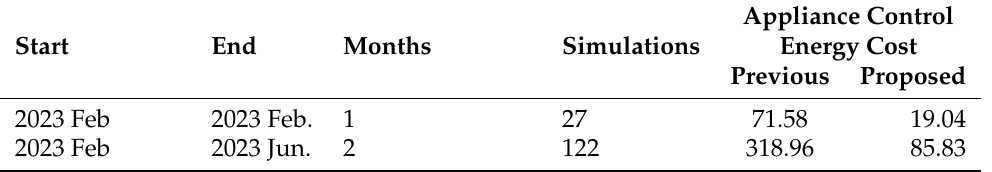
Table 14. Energy-cost comparison when increasing the number of months for dataset